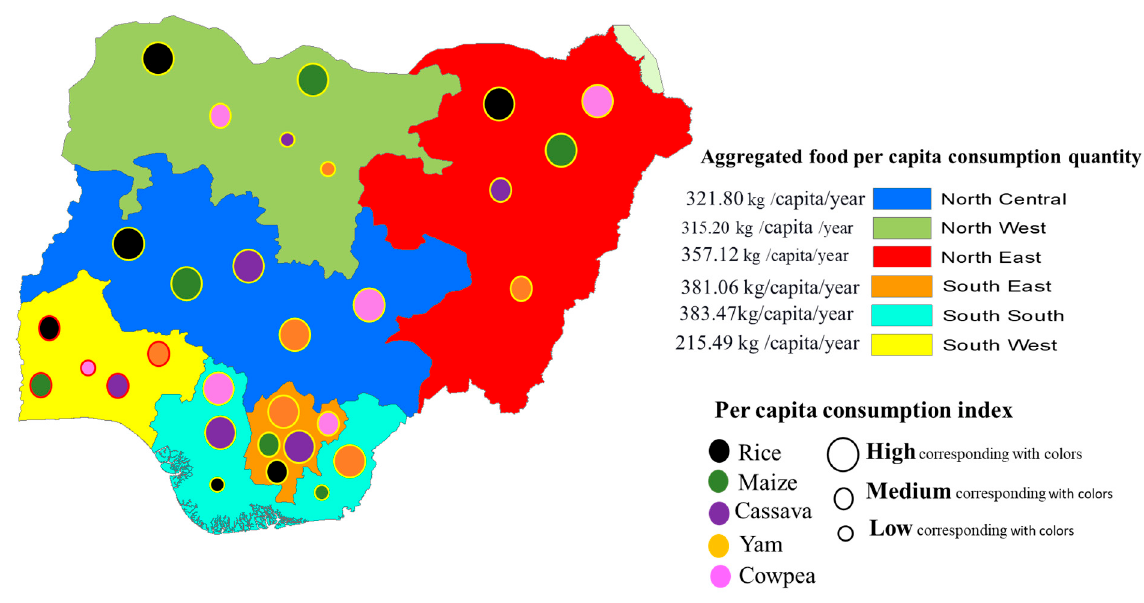
Figure 5. Pictorial representation of per annum household food consumption distribution and the rate of consumption of staple food (excluding onion and tomato) in the six geopolitical zones.